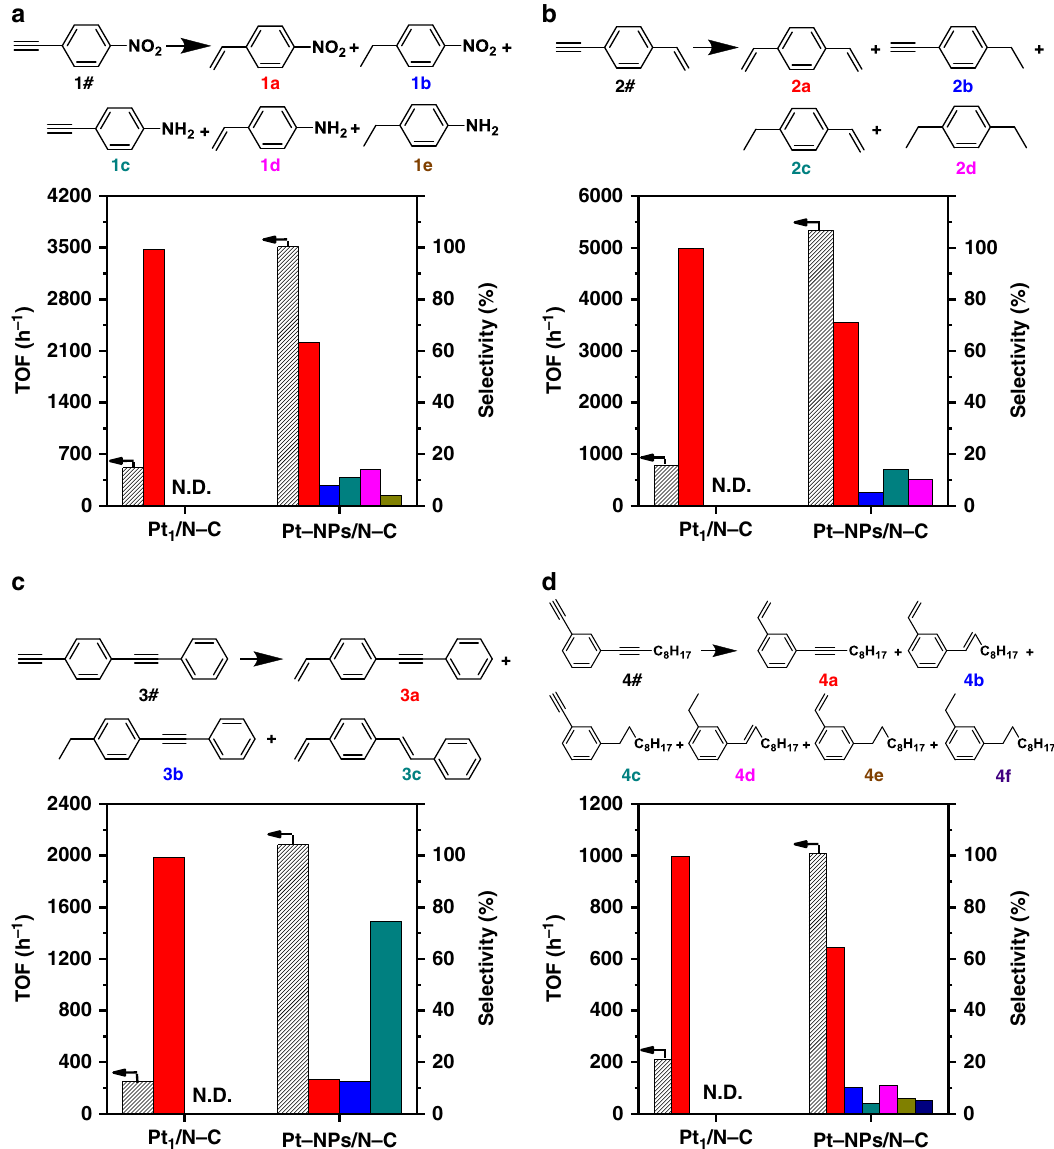
Fig. 6 Catalytic performance of Pt 1 /N – C and Pt – NPs/N – C. Reaction results for the hydrogenation of a 1-nitro-4-ethynylbenzene, b 1-ethynyl-4- vinylbenzene, c 1-ethynyl-4-(phenylethynyl)benzene, d 1-(dec-1-yn-1-yl)-3-ethynylbenzene on Pt 1 /N – C and Pt – NPs/N – C. Reaction condition: substrate (0.5 mmol), catalyst (Pt:substrate = 1:1200, mol:mol), methanol (2.0 mL), H 2 (1.0 MPa), 50 °C ( a , b ) or 80 °C ( c , d ). All the conversions were maintained at ~20%. TOF was calculated based on Pt dispersion (Pt 1 /N – C: 100%; Pt – NPs/N – C: 14.5%, estimated by particle size (6.9 nm) according to D = 1/ d Pt